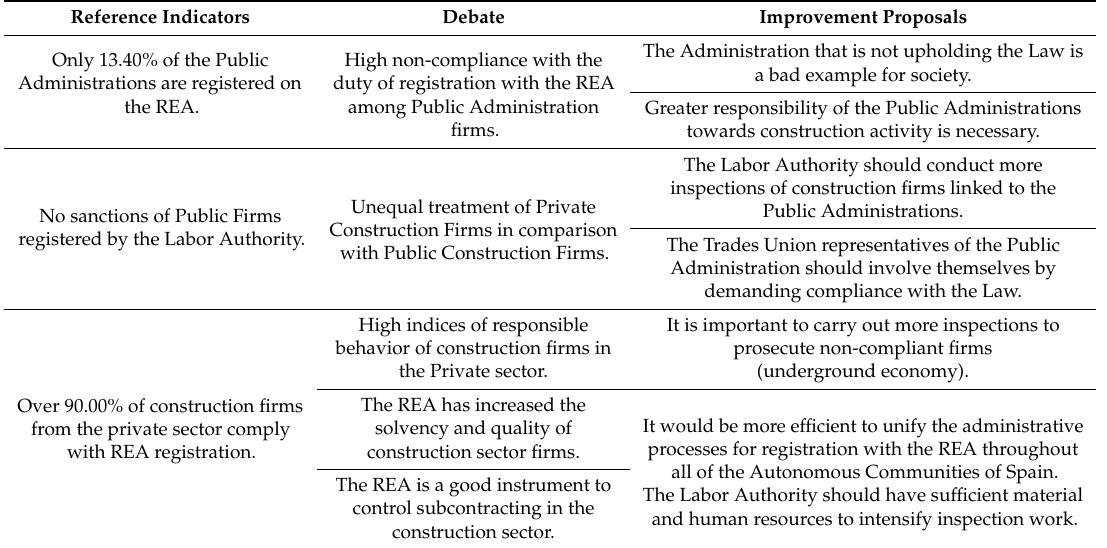
Table 7. Focus Group 1: Experts. Conclusions on registration with the REA by Public Administrations and by private sector firms, complemented by measures for